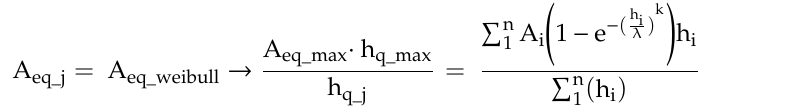
Table 3. Parameters used for the calibration of the model.